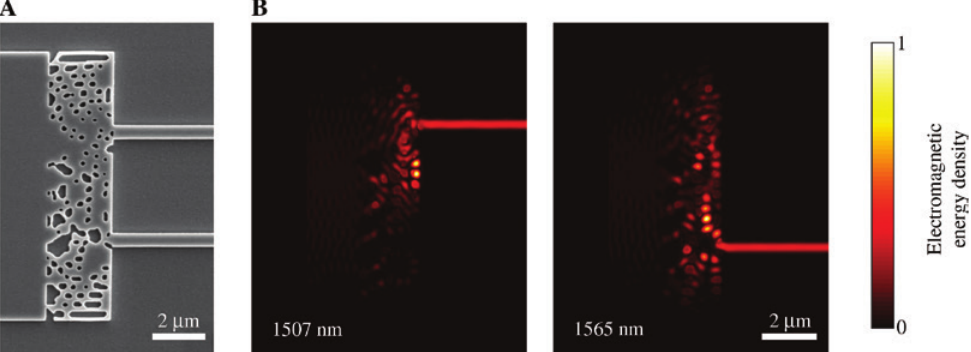
Figure 3: Two-channel focused wavelength demultiplexer with minimum feature size R = 3. (A) SEM image of the fabricated device. (B) Simulated electromagnetic energy density in a horizontal slice through the middle of the device, the wavelengths is 1507 nm and 1565 nm,